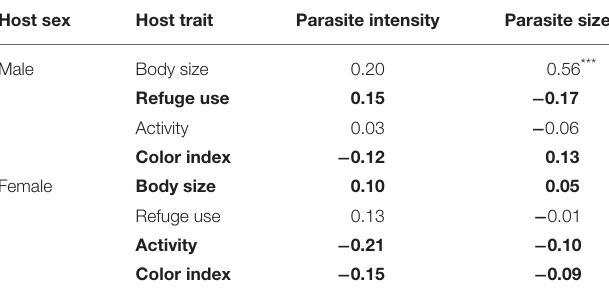
Shown are Spearman correlation coefficients with modified traits emphasized in bold. *** Indicates P < 0.001. Analysis using principal component values for color (PC1) yielded similar relationships to those shown for color